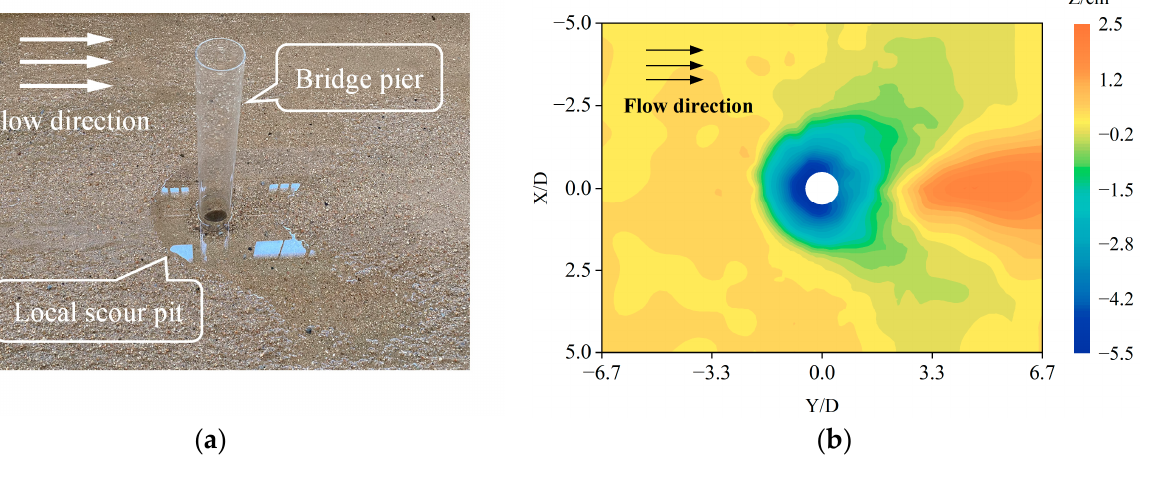
Figure 9. Local scour pit morphology of test A. ( a ) The experimental model of test A. ( b ) Local scour of test A.